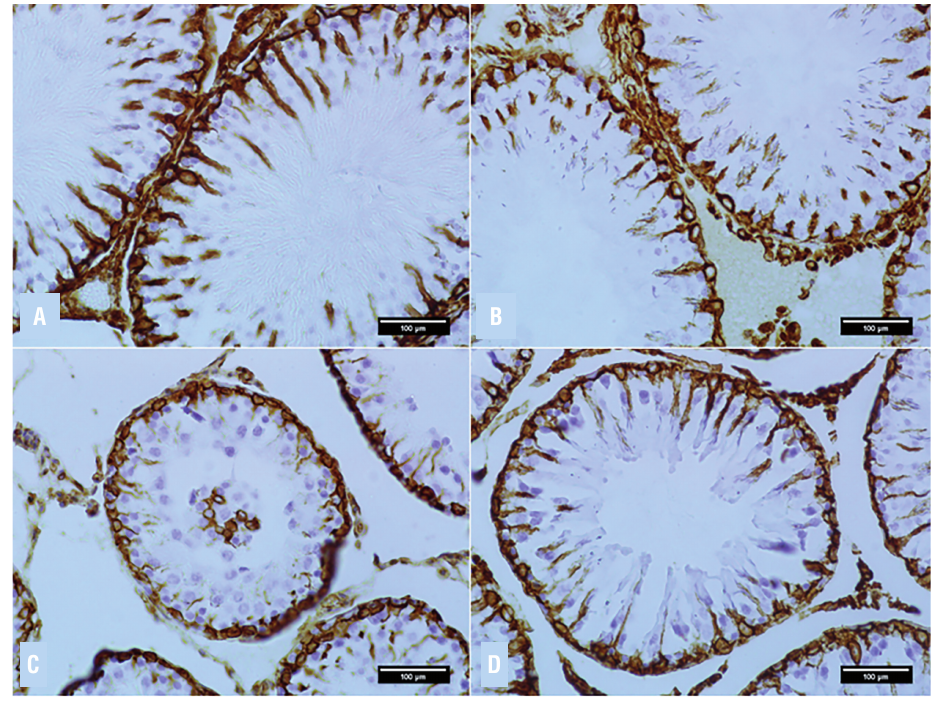
Figure 3 - Photomicrographs of the Immunohistochemistry of Seminiferous Tubules marked by Vimentin allowing the cell count of Sertoli by